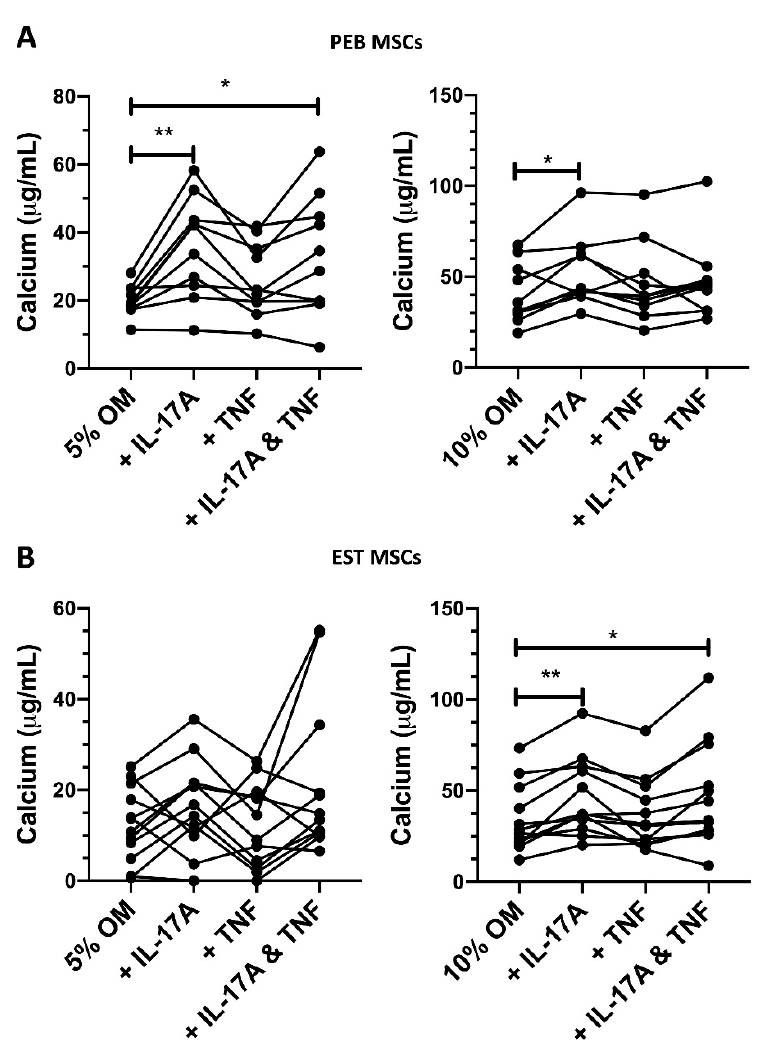
Figure 3. Changes in peri-entheseal bone (PEB) (( A ), 5% FCS RM One-Way ANOVA with Tukey Post-Hoc Test n = 10, 10% FCS Friedman’s Test with Dunn’s Multiple Comparisons n = 10) and entheseal soft tissue (EST) (( B ), 5% FCS Friedman’s Test with Dunn’s Multiple Comparisons, 10% FCS RM One-Way ANOVA with Tukey Post-Hoc Test n = 10) mesenchymal stem cell (MSC) osteogenesis following 14-day culture in osteogenic media containing cytokines and either 5% or 10% FCS. IL-17A used at 50 ng/mL and TNF at 1 ng/mL. * = p < 0.05, ** = p < 0.01. OM = osteogenic media.